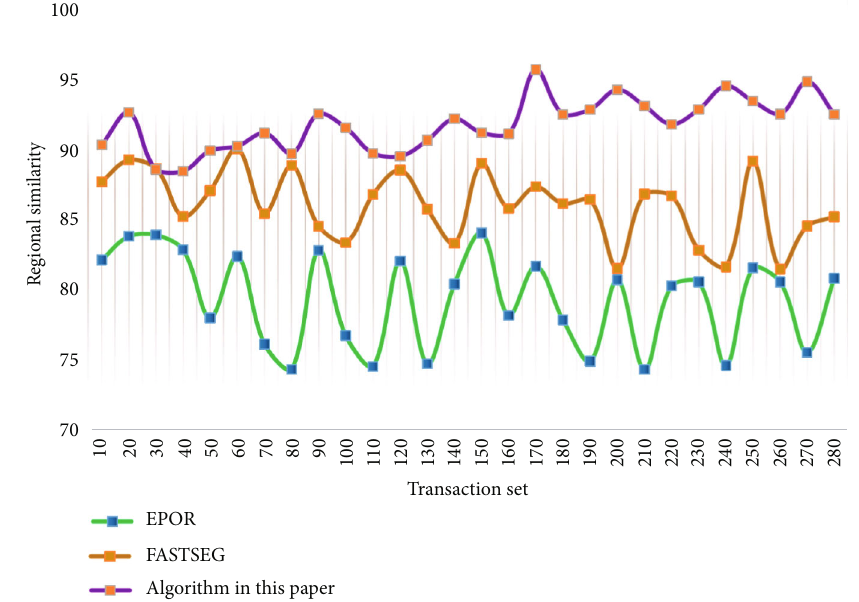
Figure 6: Experimental results of regional